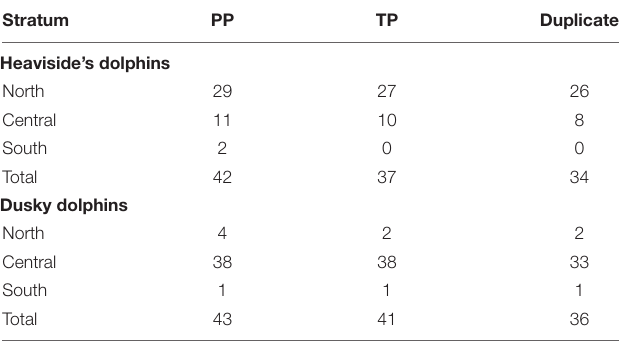
TABLE 3 | The fitted mark-recapture full independence (MR-FI) models of the detection function for Heaviside’s and dusky dolphins, and probabilities of detection obtained from the models.